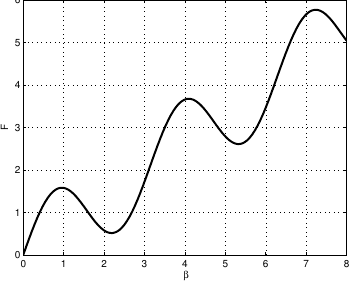
Figure 1. Function F ( β ) at Bm = 1 .